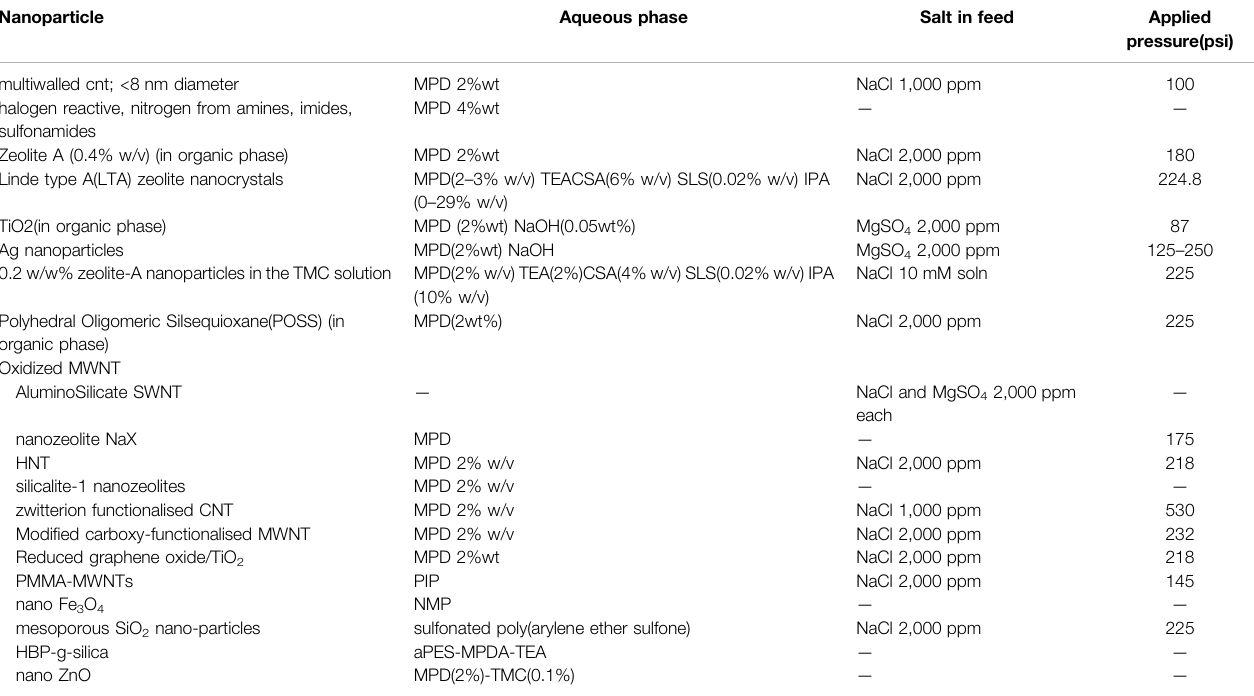
TABLE 2 | Summary of nanoparticles used in TFNs (Fathizadeh et al., 2011; Daraei et al., 2012; Huang et al., 2013a; Kim E. S. et al., 2013; Alam et al., 2013; Baroña et al., 2013; Huang et al., 2013b; Chan et al., 2013; Shen et al., 2013; Zhao et al., 2014; Ghanbari et al., 2015; Safarpour et al.,